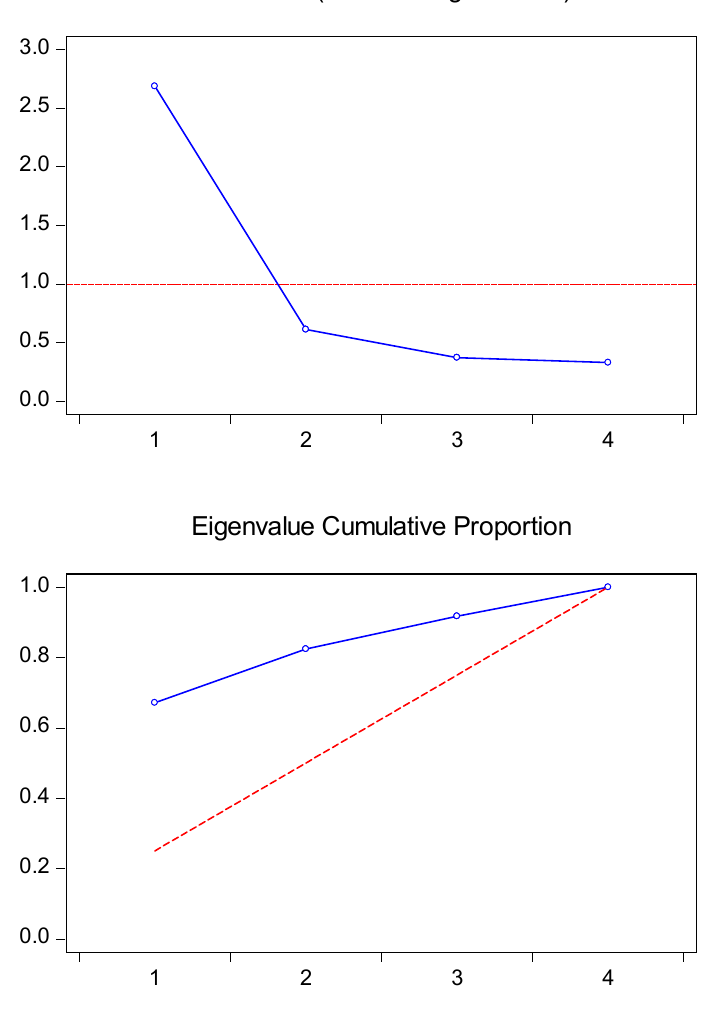
Table 5. Vector autoregression test.